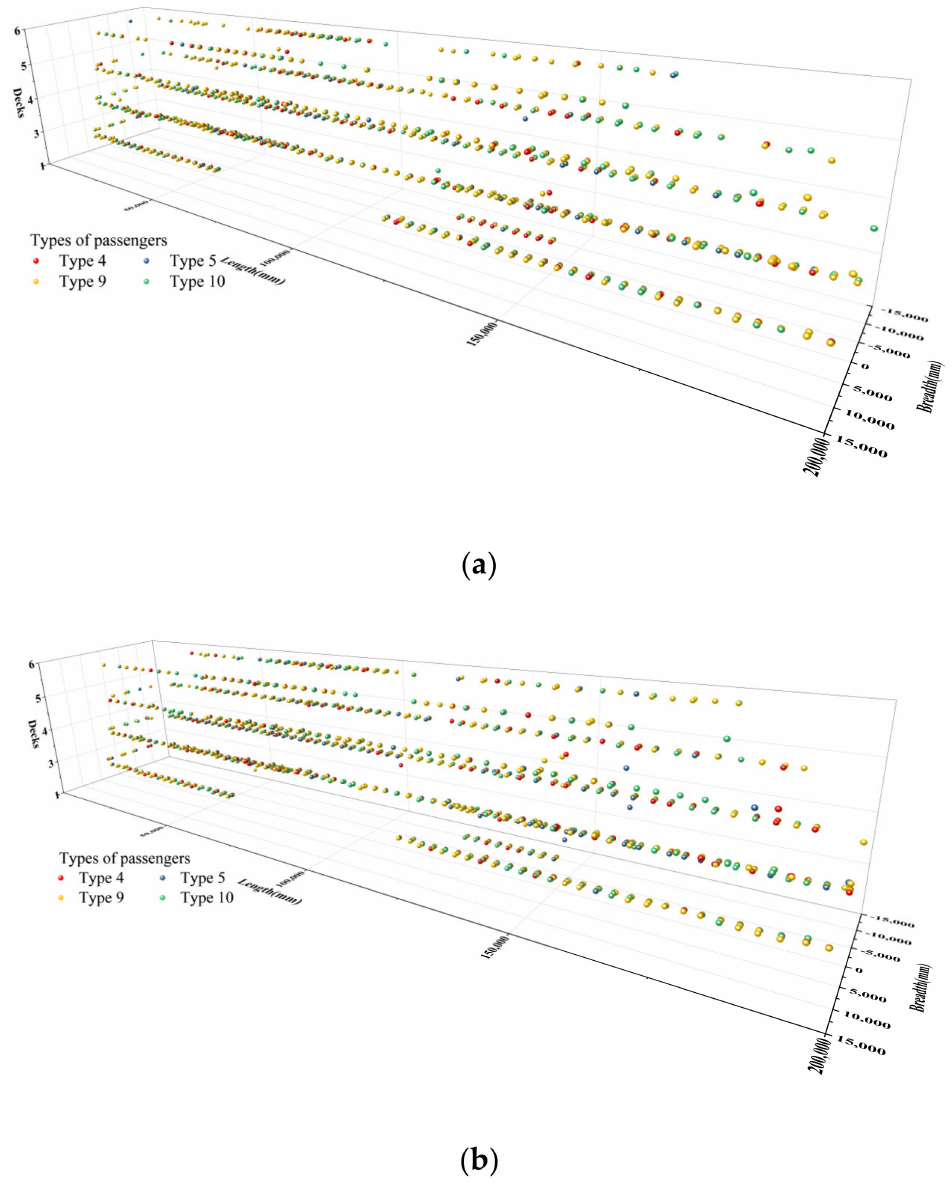
Figure 12. The initial positions of the first 10% of arriving passengers under night scenarios. ( a ) The night-individual scenario; ( b ) the night-group